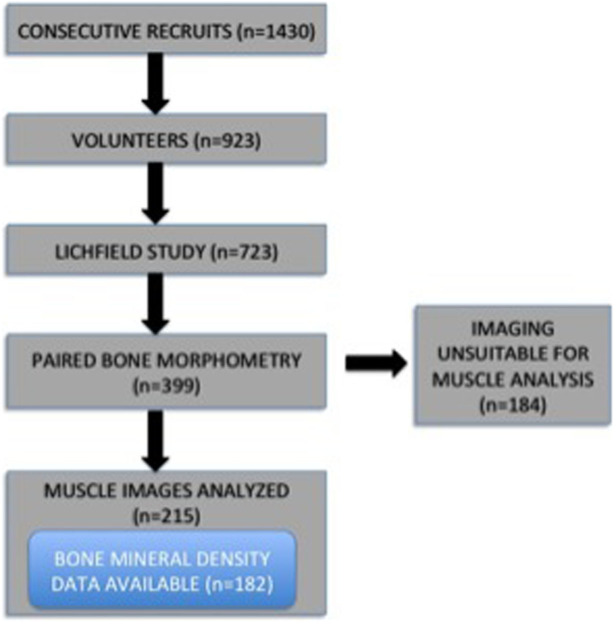
Flowchart of paired muscle and bone image analysis subcohort.